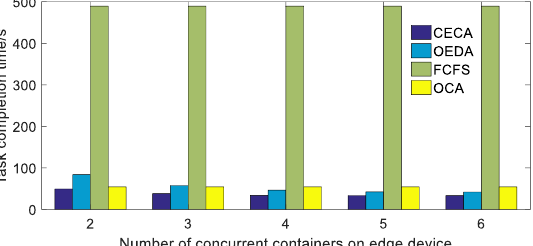
Figure 5. The effect of the number of concurrent containers in the edge device on the task completion time.